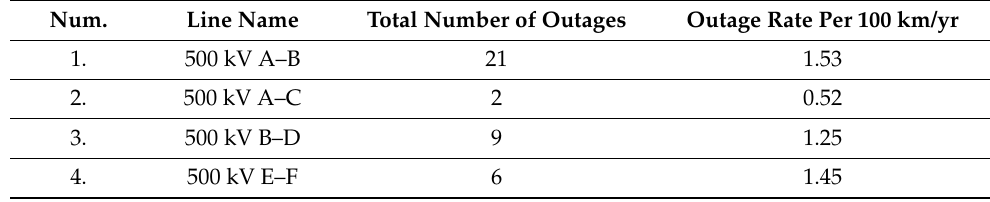
Table 2. Line performance comparison for 500 kV lines in TNB.